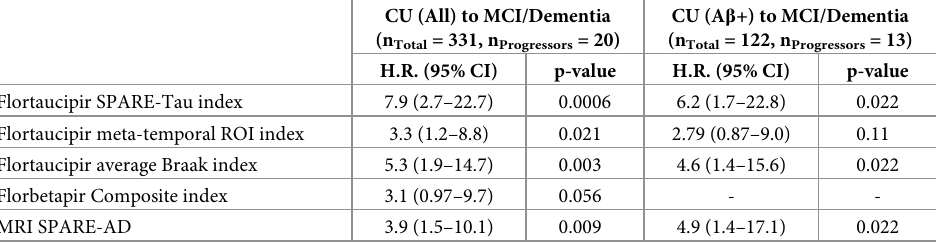
Table 1. Prediction of clinical progression in CU participants. Analyses adjusted by age, education, and sex. Bio- markers values were classified as normal or pathological to predict clinical progression. Bonferroni-Holm multiple comparison correction applied.